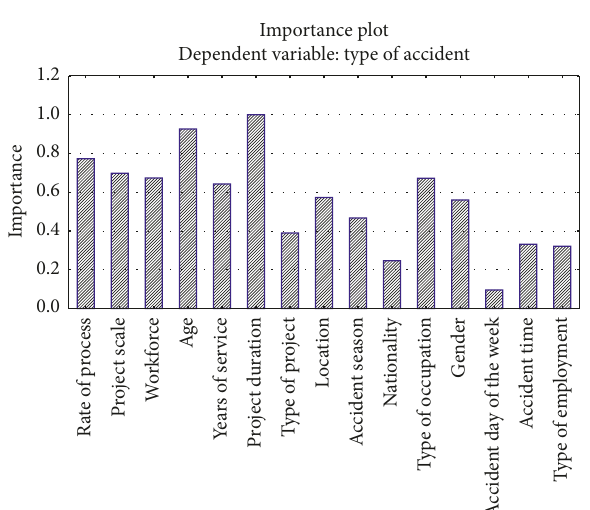
Figure 5: Importance of dependent variables of the SGB model.